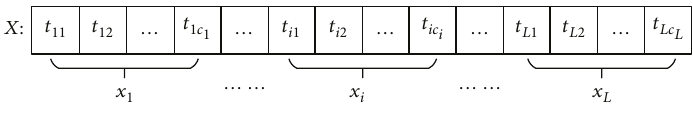
Figure 3: Illustration of the